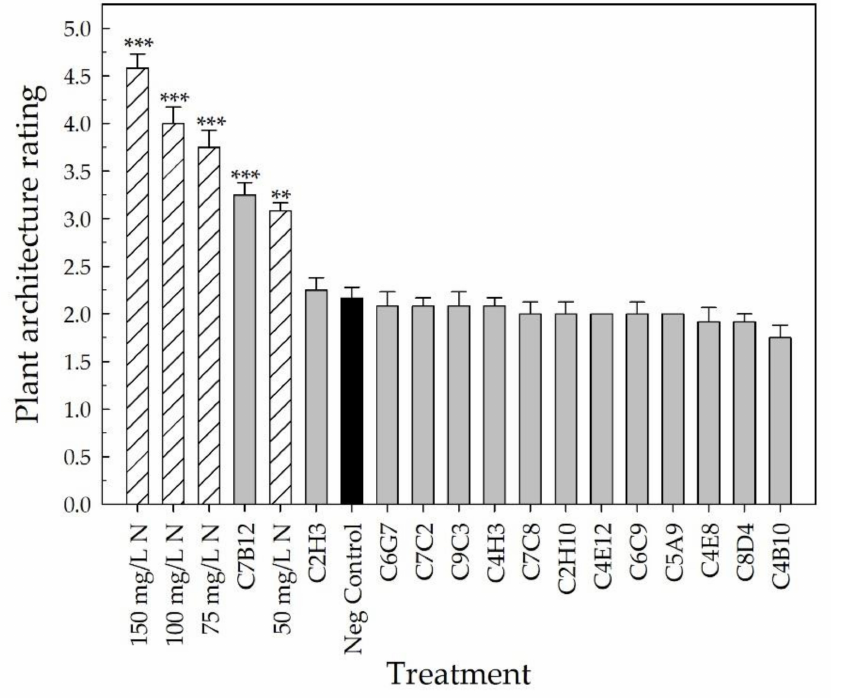
Figure 5. A plant architecture rating at harvest in the greenhouse validation trial was used to evaluate Petunia × hybrida ‘Picobella Blue’ treated with the 14 bacterial strains selected from the high-throughput greenhouse trials ( n = 12). The rating scale ranged from 1 (vegetation did not cover the pot with ~40% of soilless growing media visible; plant appeared stunted) to 5 (vegetation covered pot fully; vegetation was not leggy). All plants treated with bacteria were fertilized with 25 mg L − 1 N (gray bars). The black bar represents the negative control (no bacterial treatment) fertilized with 25 mg L − 1 N, and the white bars with slanted lines represent the four positive controls (no bacterial treatment) fertilized with either 50, 75, 100, or 150 mg L − 1 N. The plant architecture rating was analyzed using the Kruskal–Wallis rank sum test, followed by the Dunn’s test of multiple comparisons with FSA. Significance is represented by **, and *** at p ≤ 0.01, and p ≤ 0.001, respectively. Bars represent the mean, and error bars denote standard